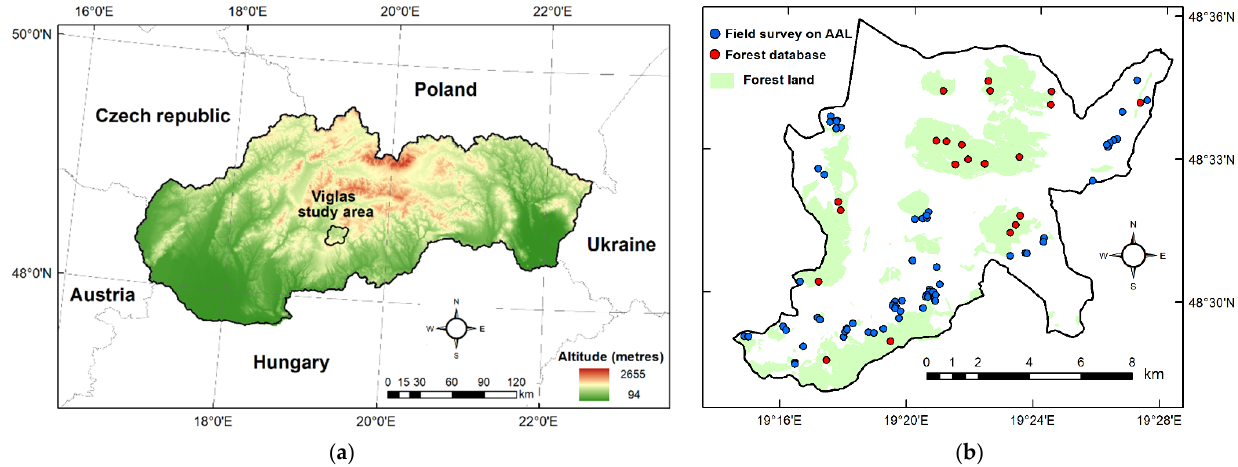
Figure 1. ( a ) Location of the Viglas study area in central Slovakia (black polygon); ( b ) localization of the field survey plots on abandoned agricultural land (blue circles) and the plots from forestry database (red circles) in study area.